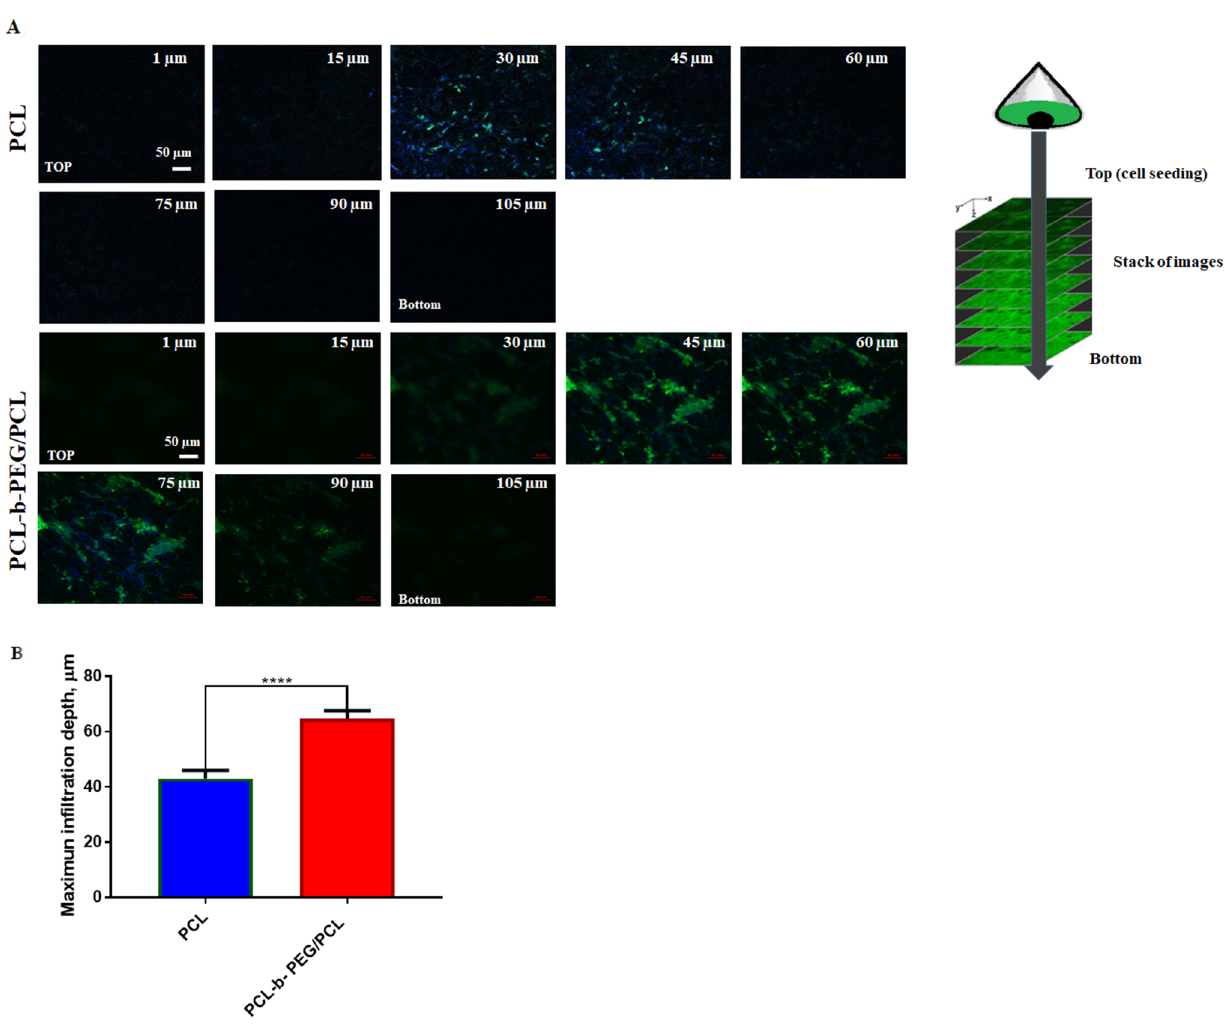
B Infiltration depth expressed as a percentage of the total scaf- fold thickness of 3T3 GFP 3T3 fibroblasts cultured on PCL and PCL-b-PEG/PCL scaffolds, with the same average fibre diameter, over 5 days. Experiments were carried out in triplicate from at least three different scaffolds (means ± SD). Ns for P > 0.05, * for P ≤ 0.05, **P ≤ 0.01, ***P ≤ 0.001, ****P ≤